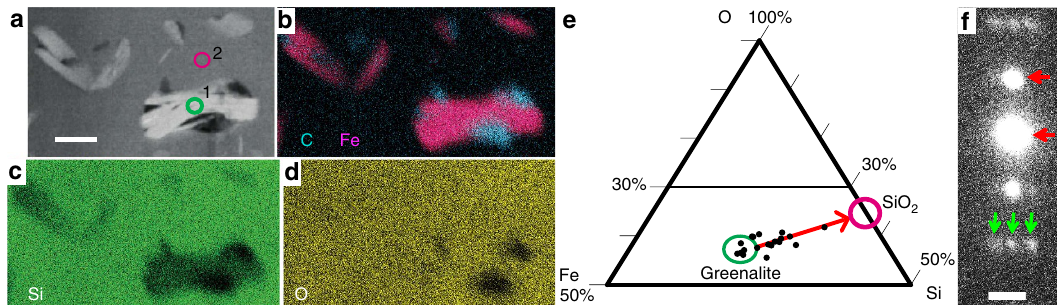
Figure 3 | Intra-microfossil greenalite. ( a – d ) STEM of greenalite in quartz. ( a ) Dark-field image. Scale bar, 200nm. Circles numbered 1 and 2 outline target areas of EDXS and EELS spectra (displayed in Supplementary Fig. 15 with corresponding numbers). ( b – d ) EDXS mappings of Fe (pink in b ), organic C (cyan in b ), Si (green in c ), O (yellow in d ) in the region in a . The crystals in the green circle traverse the FIB section, allowing EDXS analyses without quartz interference, as confirmed by Si EELS spectra. ( e ) Ternary Fe–Si–O (atomic %) plot derived from EDXS spectra (Supplementary Fig. 15c): quartz-free greenalites (including that numbered 1 in a ) plot in the green circle, whereas other crystals plot on a mixing line with quartz (pink circle), indicating that all greenalite crystals have a similar composition. The Si/O ratio of 0.32 ( n ¼ 4 quartz-free crystals) is consistent with the general formula of greenalite: Si 2 O 5 (OH) 4 (Fe 2 þ ,Fe 3 þ ) 2–3 . EELS spectra display a Fe 3 þ /Fe total o 4.5 % (Supplementary Fig. 15e), indicating a composition close to Si 2 O 5 (OH) 4 (Fe 2 þ ) 3 . ( f ) SAED pattern recorded on the region numbered 1 in a . Scale bar, 1nm (cid:3) 1 . Arrows indicate lattice spacing diagnostic of greenalite: 7.2Å (0,0,1) planes (red), and 23Å superlattice (green).